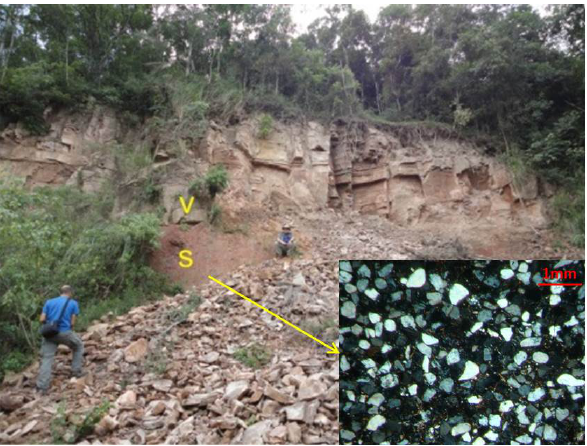
Fig. 8. Outcrop in the Venâncio Aires area (Rio Grande do Sul State), where a silicic volcanic unit of the ATP type (V) rests on a reddish sedimentary layer (S) lacking peperitic interaction. On the right lower corner a photomicrograph of the sandstone ( X polariz- ers).